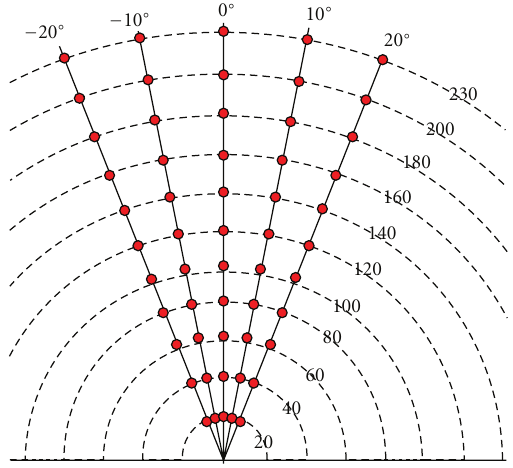
Figure 12: Calibration positions for a particular section in the